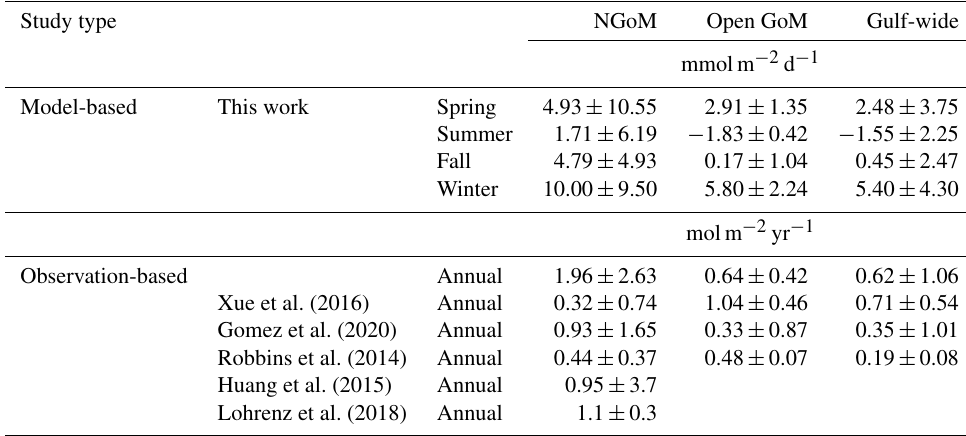
Table 3. Air–sea CO 2 flux comparison among this work and previous studies for the GoM. The mean estimate is followed by the standard deviation with the ± symbol. Positive flux indicates the ocean is a carbon sink with regard to the